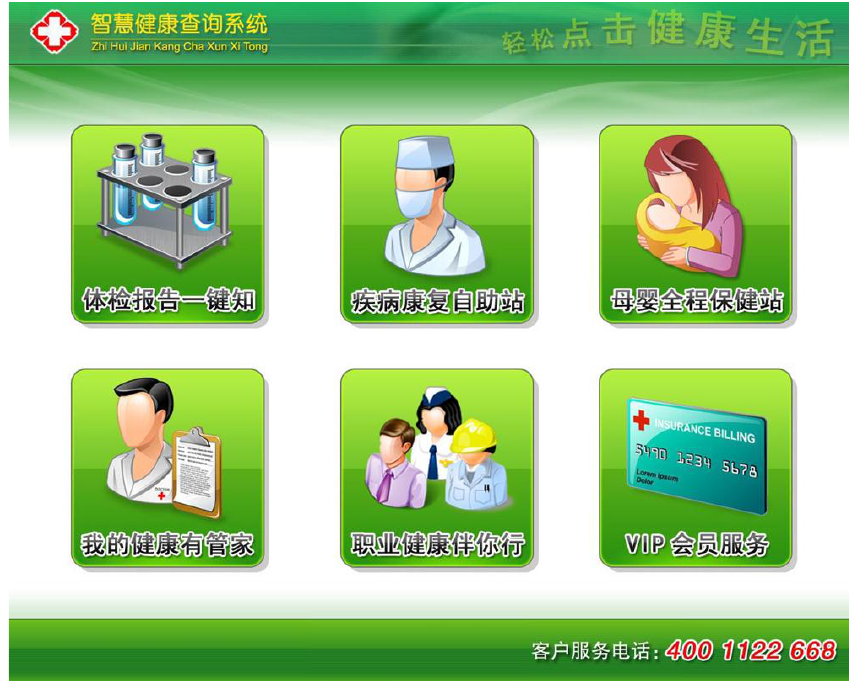
Figure 3: The opening screen of the Intelligent Health Management Self-Service terminal (the two top left icons indicate the “One Stop Medical Report” and “Self-Service Disease Recovery” diagnostic and consultation